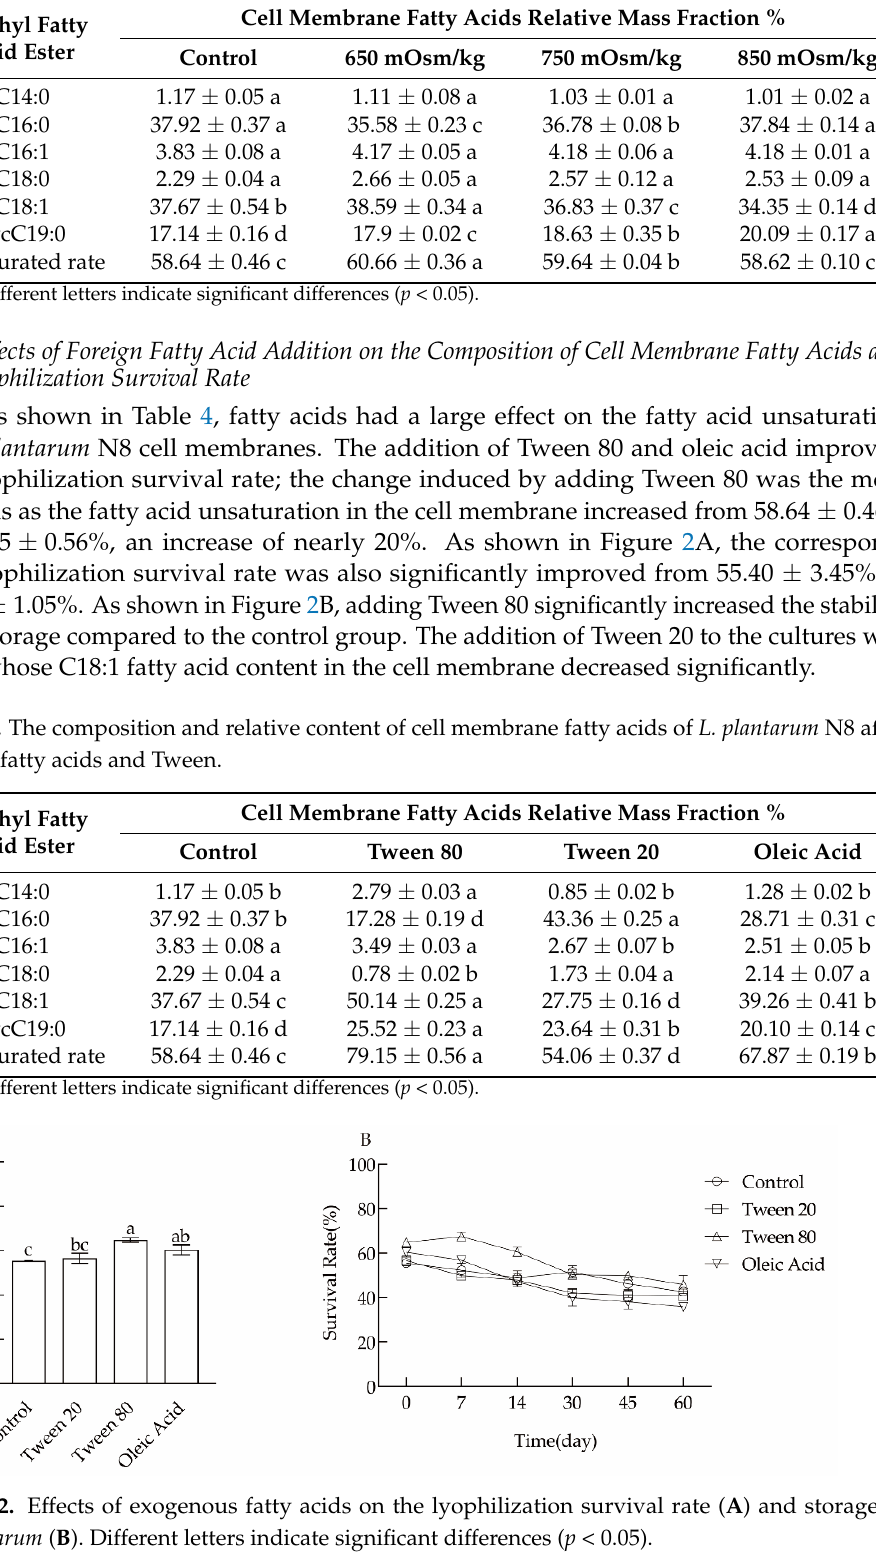
Table 3. The composition and relative content of cell membrane fatty acids of L. plantarum N8 after hypertonic stress treatment.